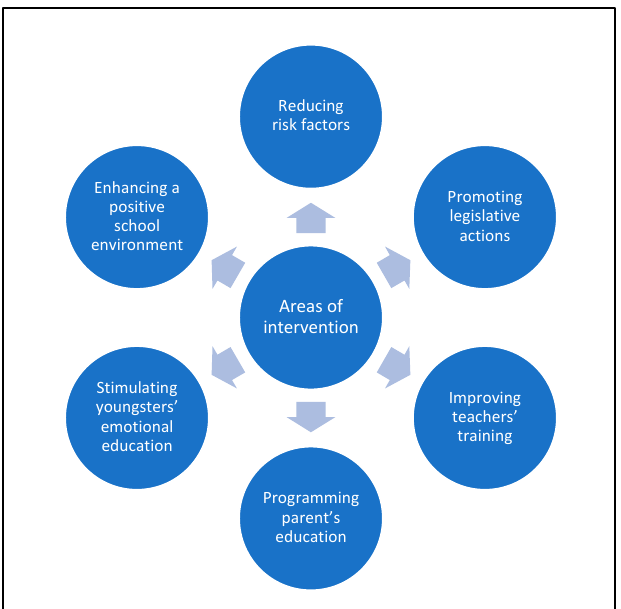
Figure 7. This figure represents the areas of interventions studied by articles included in the results of this review.